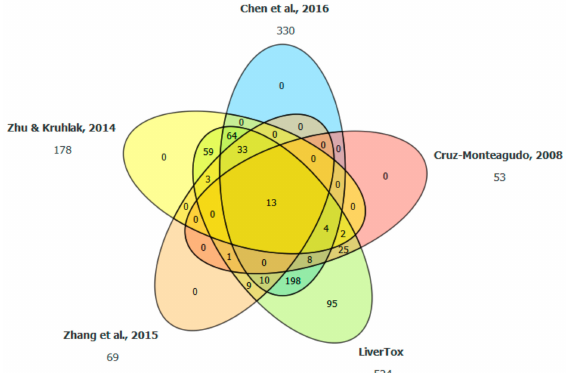
Figure 1. Venn diagram of selected compounds. Compounds in our dataset that we classified either as DILI-positive or DILI-negative were extracted from di ff erent literature sources. Only LiverTox contained compounds that were not present in any of the other